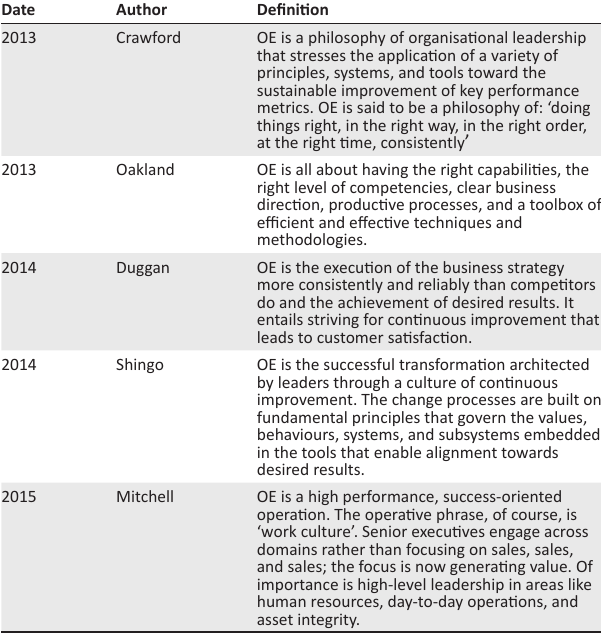
TABLE 2 : Operational excellence